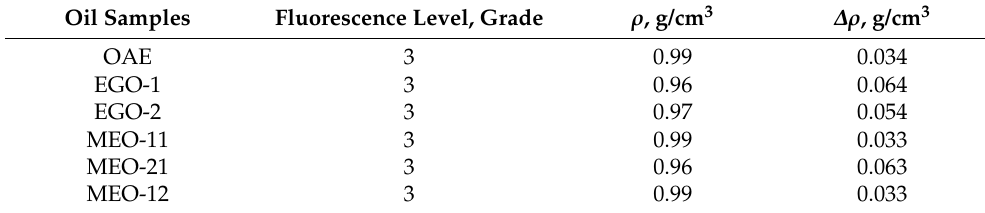
Table 1. Performance test results of different oil